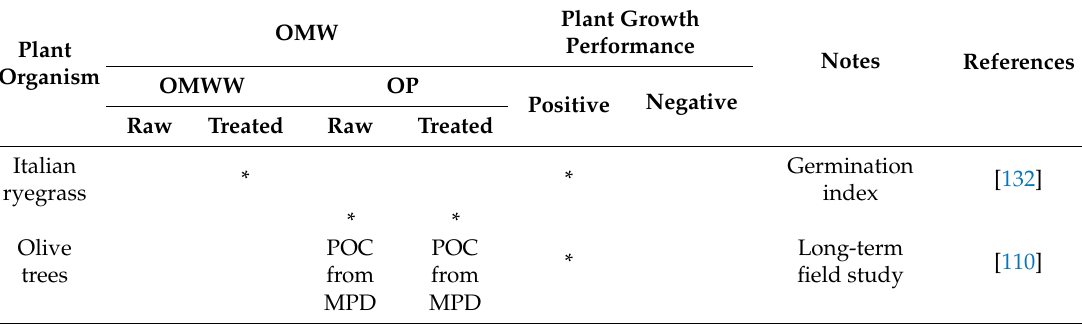
Table 2. Recent studies on the e ff ects of OMWs on plants growth and yield. * indicates the type of OMW and the plant growth performance